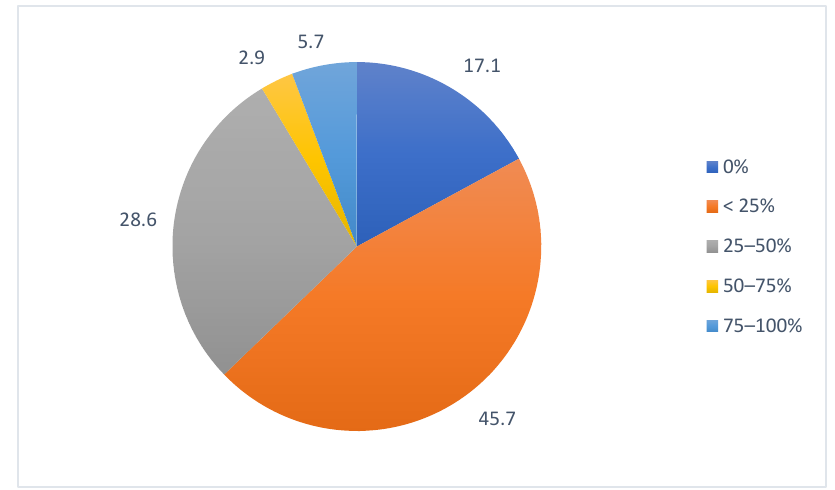
Figure 4. Estimation of time savings regarding target volumes segmentation.